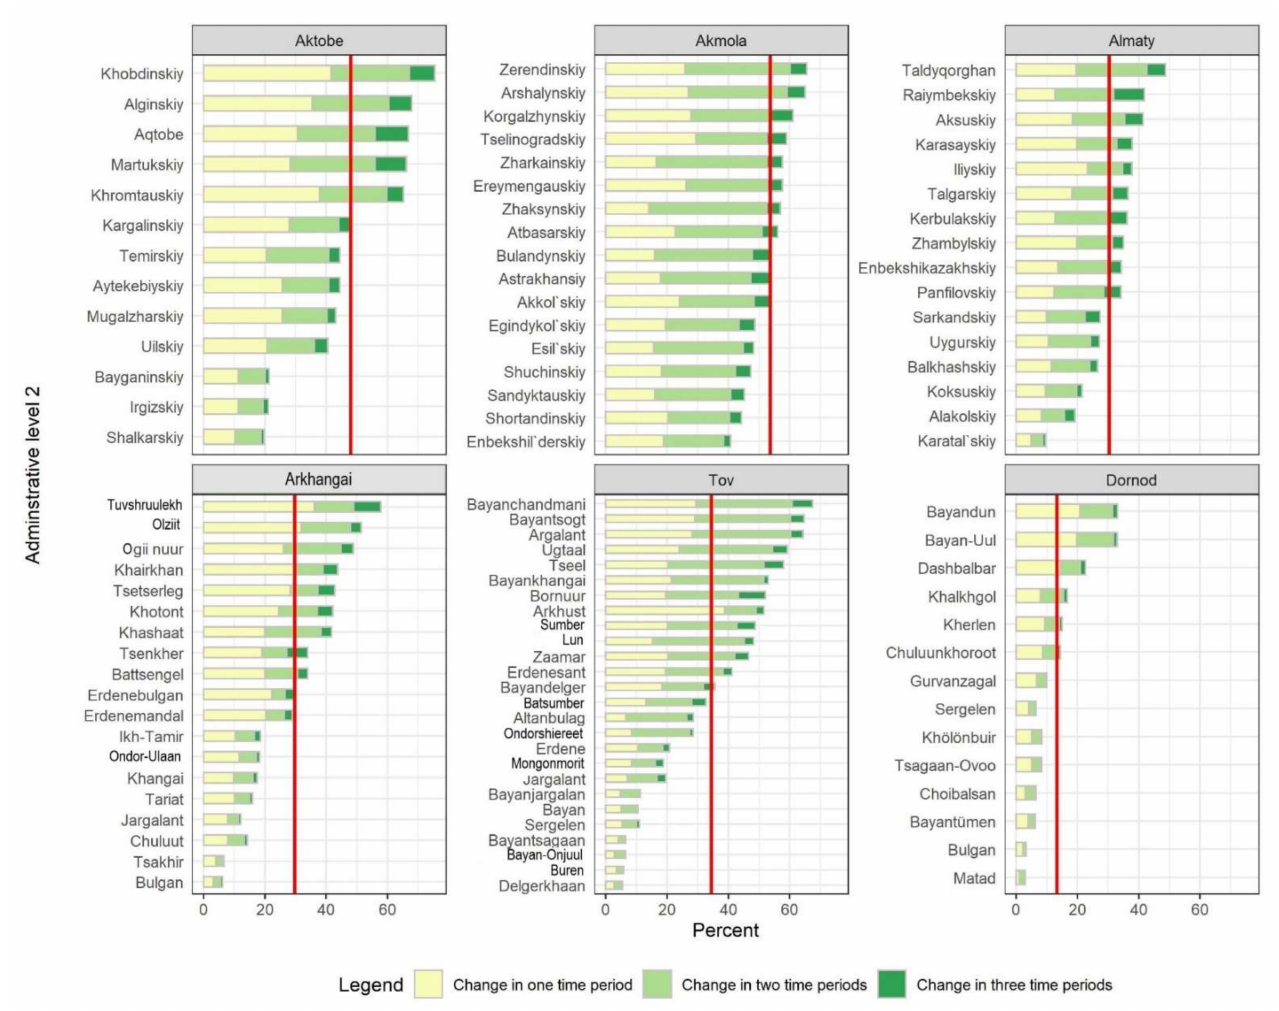
Figure 6. Accumulative land cover change intensity (accumulative iLCC ) at county level by province over three decades (1990–2020). Vertical red lines denote the average of accumulative land cover change intensity of the